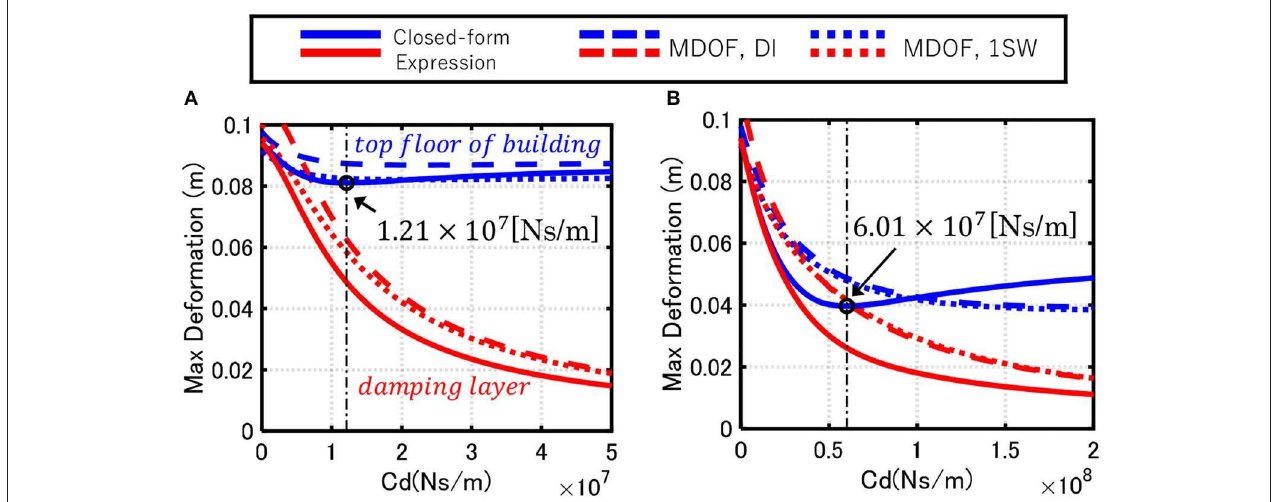
FIGURE 7 | Comparison of maximum displacements among closed-form expression for SDOF model under double impulse, time-history response analysis for MDOF model under double impulse and time-history response analysis for MDOF model under one-cycle sine wave. (A) Original Model and (B) Stiffer Model.